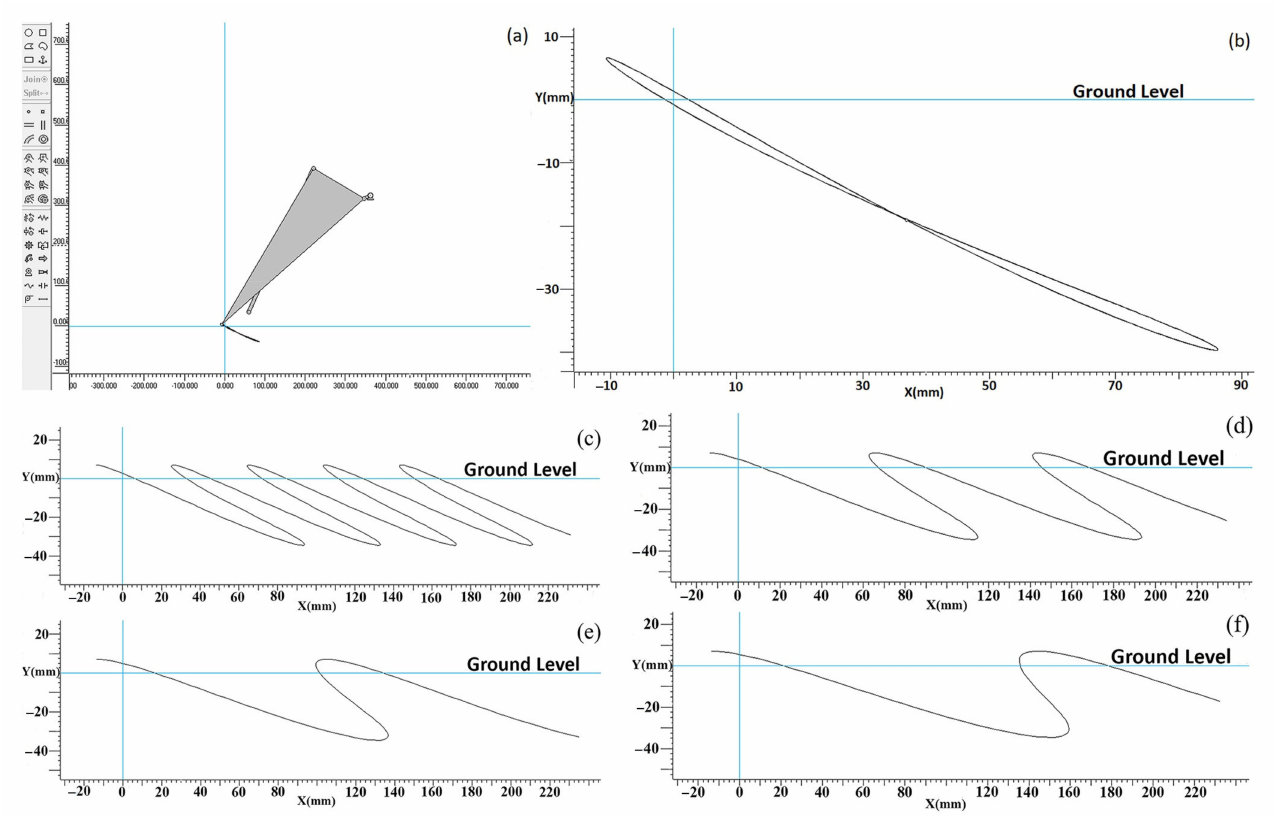
Figure 12. HGA-based synthesized mechanism in Working Model 2D software: ( a ) simulated mechanism, ( b ) the side view of the tracked path in the static state of the mechanism, ( c – f ) the side view of the tracked paths in the dynamic states of the mechanism at different travel speeds, respectively, are 2 km h − 1 , 4 km h − 1 , 6 km h − 1 , 8 km h − 1